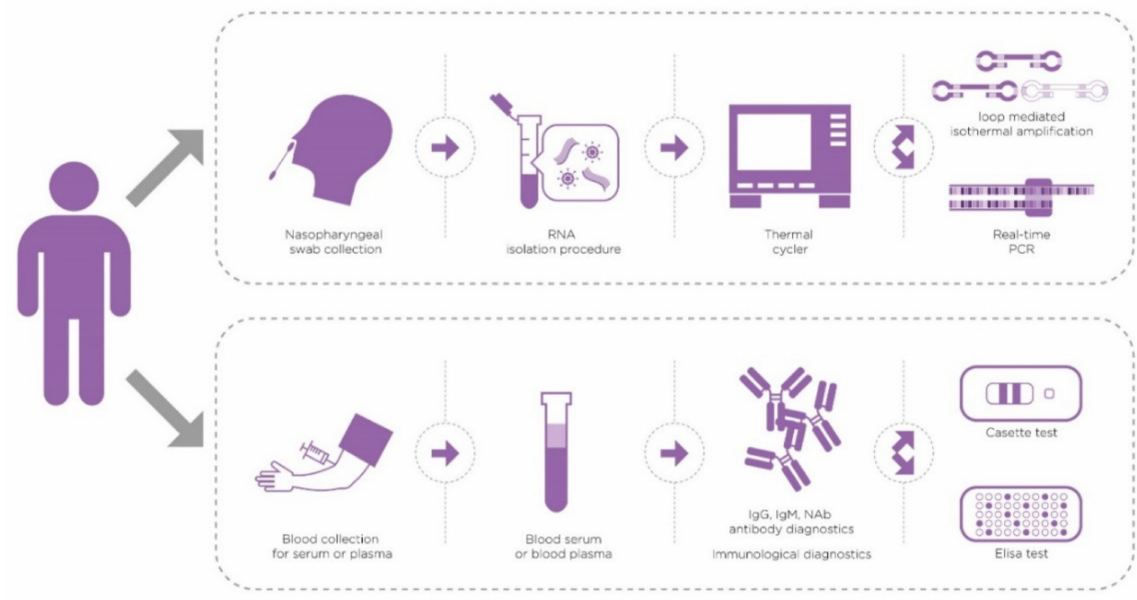
Figure 1. Flow chart of the possible diagnostic processes for